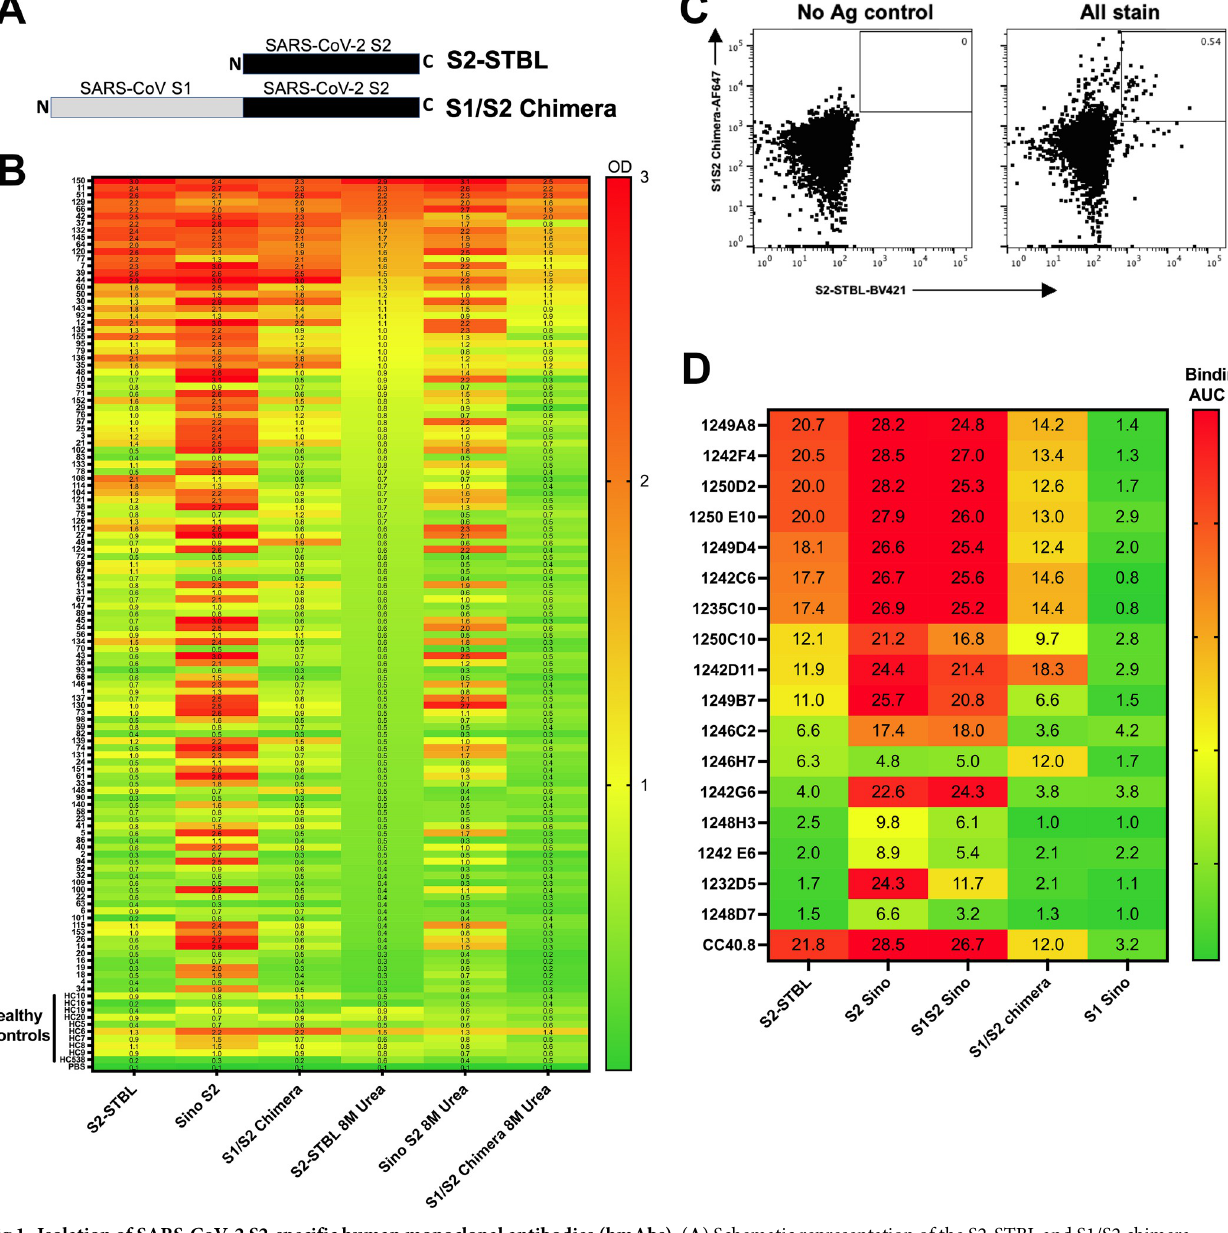
Fig 1. Isolation of SARS-CoV-2 S2-specific human monoclonal antibodies (hmAbs). ( A ) Schematic representation of the S2-STBL and S1/S2 chimera proteins used as baits for ELISA and flow cytometry. (B) Human plasma from either convalescent or healthy subjects was diluted 1:1000 in PBS and tested in duplicate in an ELISA against indicated proteins; Absorbance at 450 nM is shown. Each row is an individual subject. (C) Representative gating strategy for S2 + B cell isolation. Initial plots are gated on live CD3 − CD4 − CD14-annexinV-CD19+CD27+ B cells. (D) hmAbs were tested at 10 and 1 μ g/ml in duplicate by ELISA for binding to indicated protein; area under the curve (AUC) is